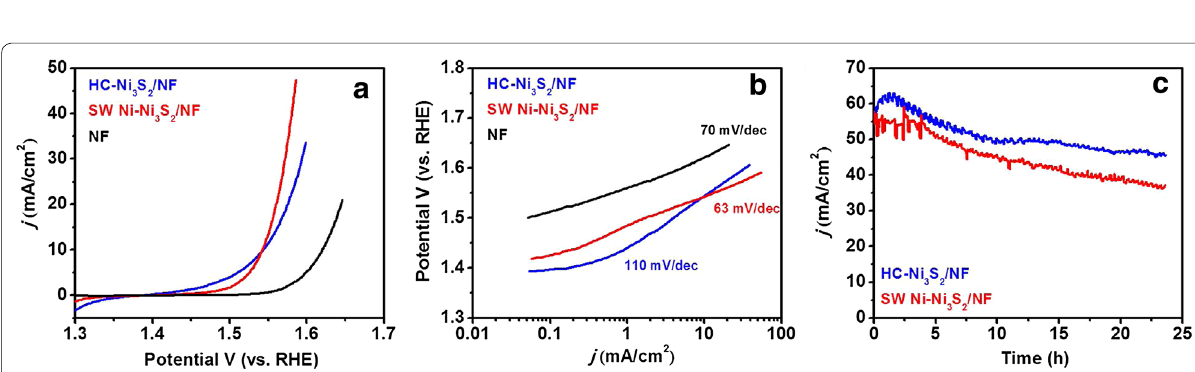
Fig. 5 Electrochemical OER performance. a Polarization curves of SW Ni–Ni 3 S 2 /NF, HC–Ni 3 S 2 /NF and bare NF at a scan rate of 1 mV/s, b correspond- ing Tafel plots and c the chronopotentiometry test [Electrolyte: 1 M KOH and CV scan rate 1